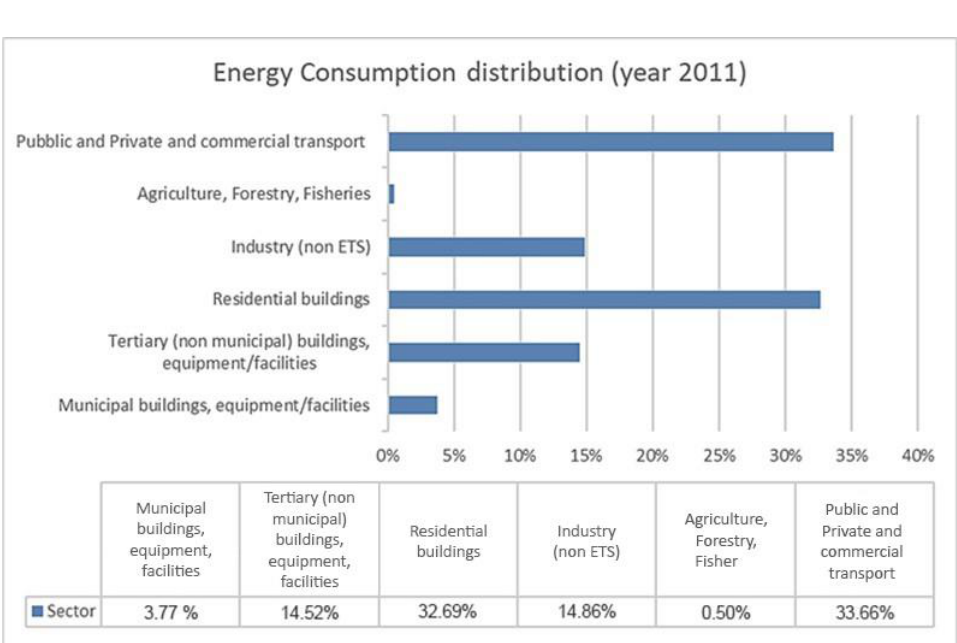
Figure 3. Energy consumption distribution by sector (2011).